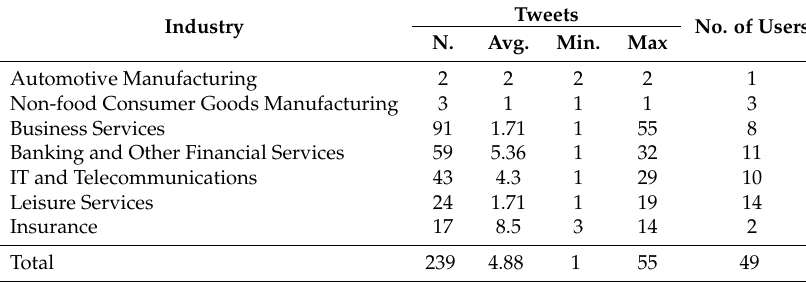
Table 10. Twitter Activity by